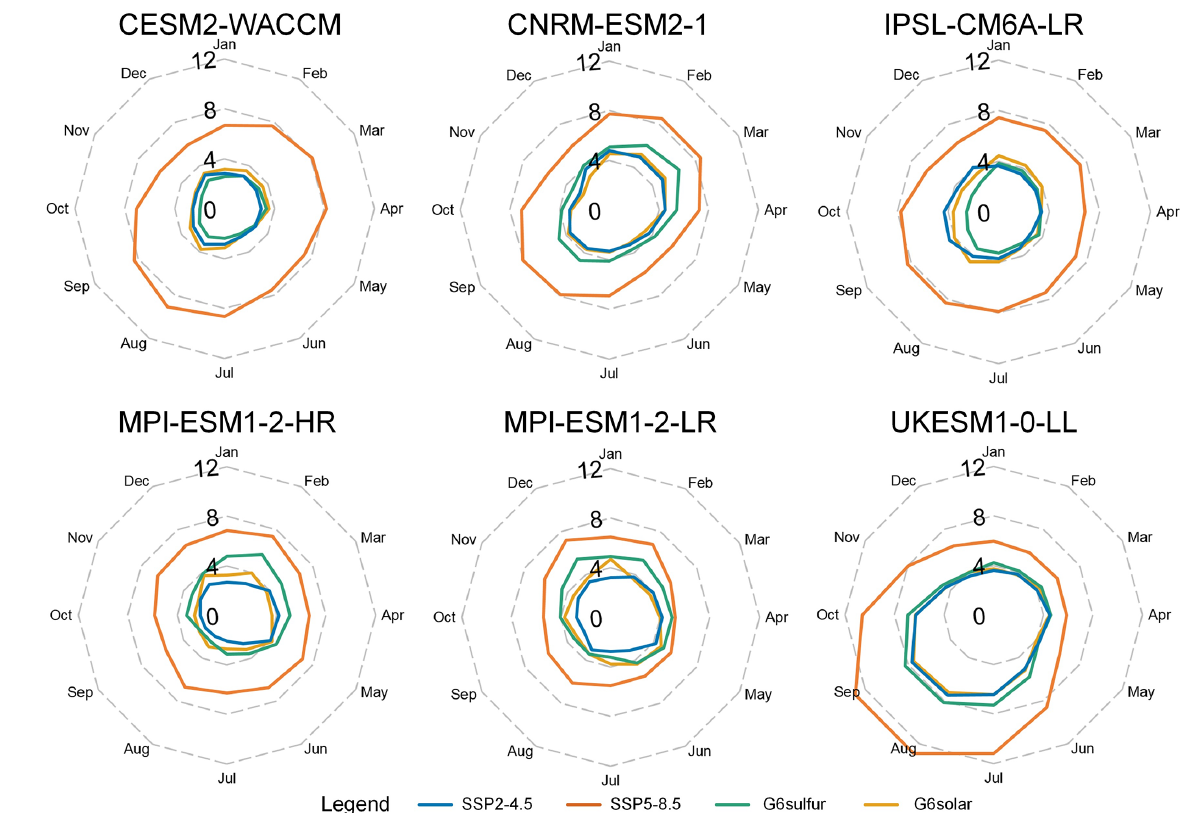
Figure 9. Monthly soil temperature change between 2020 and 2100. Warming in monthly soil temperature ( ◦ C) for each ESM over the period 2020–2100 under the SSP2-4.5, SSP5-8.5, G6sulfur, and G6solar